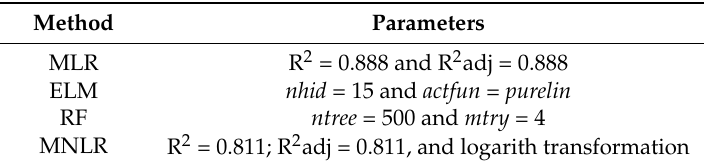
Table 5. Methods and their parameters used.